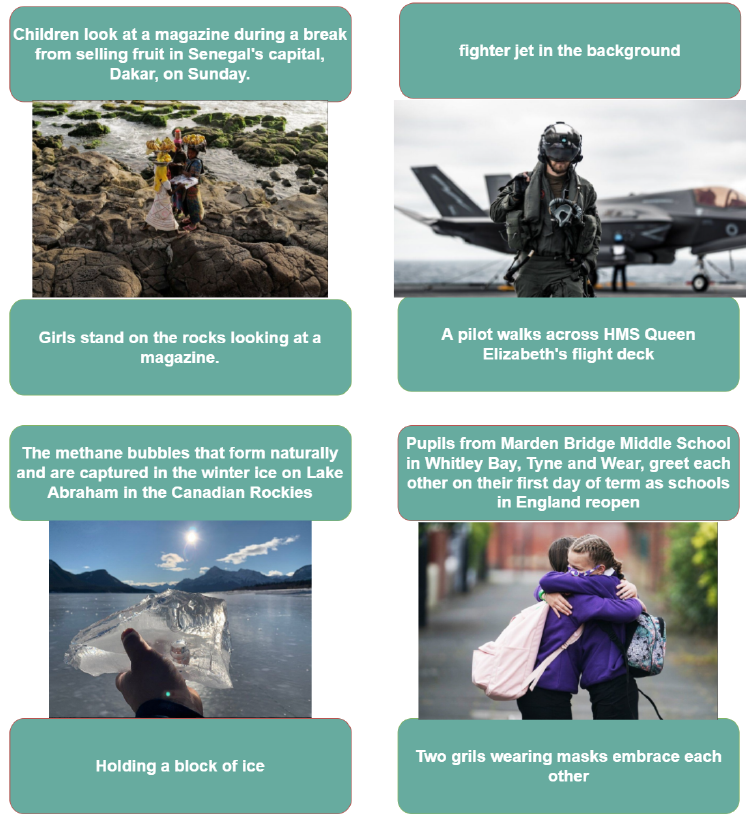
Figure 9. False positive cases. Not-out-of-context captioned image is classified as